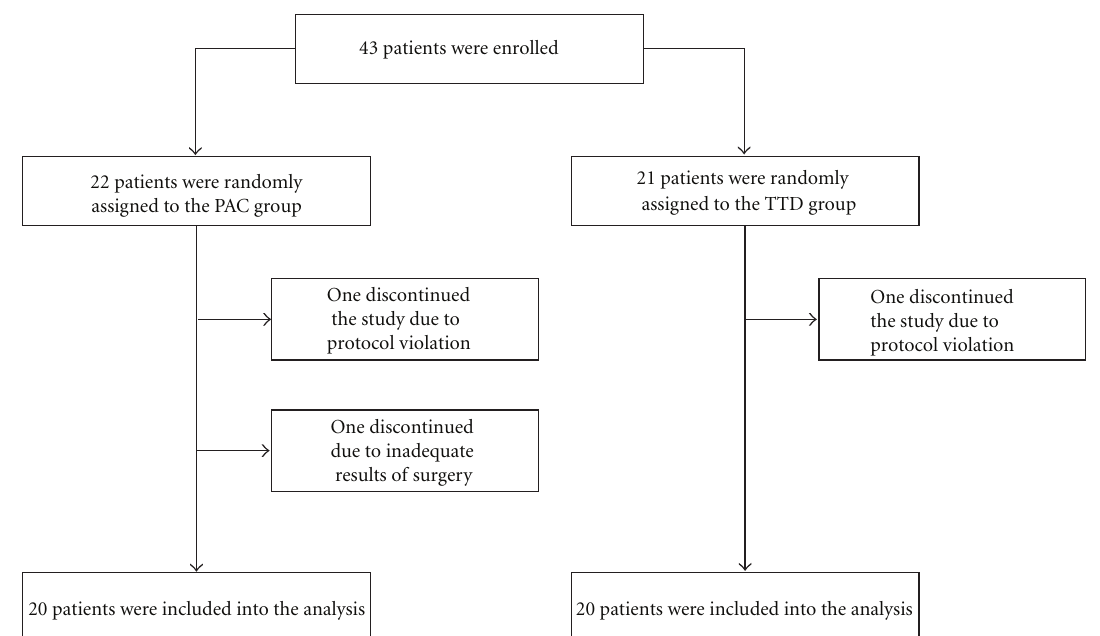
Figure 1: Flow diagram detailing the conduct of the study. PAC: pulmonary arterial catheter; TTD: transpulmonary thermodilution.